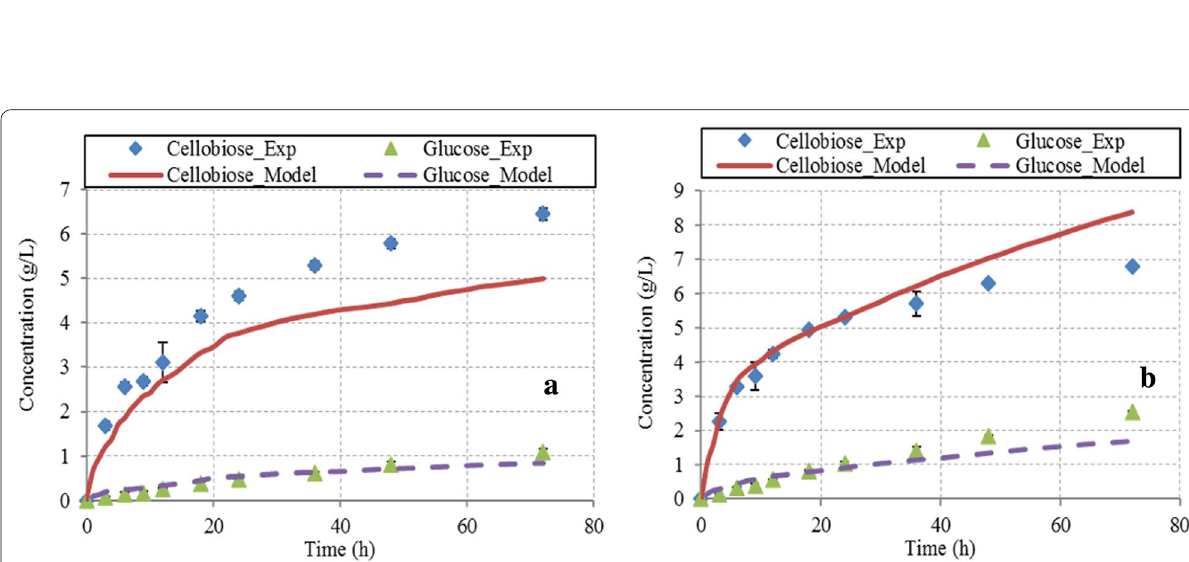
Fig. 9 Comparison of model simulations and experimental observations of sugar production during hydrolysis of filter paper (25 g/L) at a CBH I loading of 5 mg/g cellulose, b CBH I loading of 15 mg/g